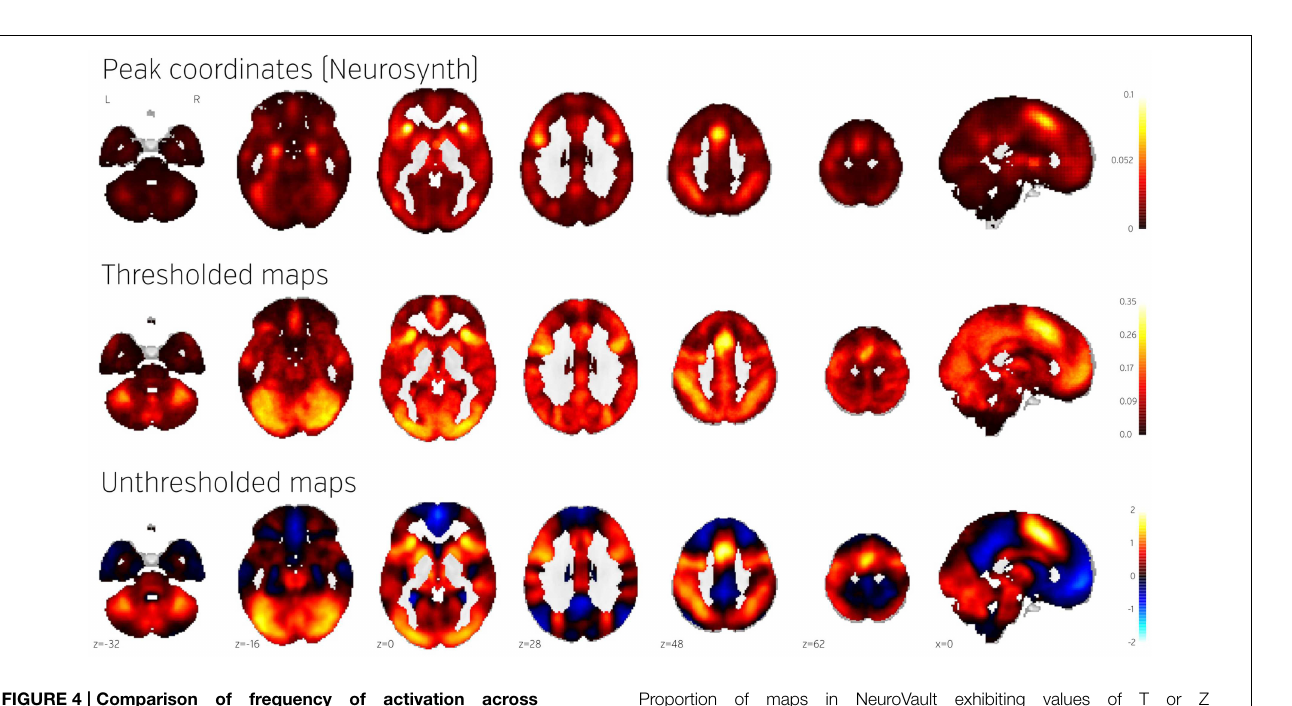
FIGURE 4 | Comparison of frequency of activation across human brain studies obtained using different methods. Top : Prior activation probability map obtained from coordinate-based meta-analysis using NeuroSynth. Middle :